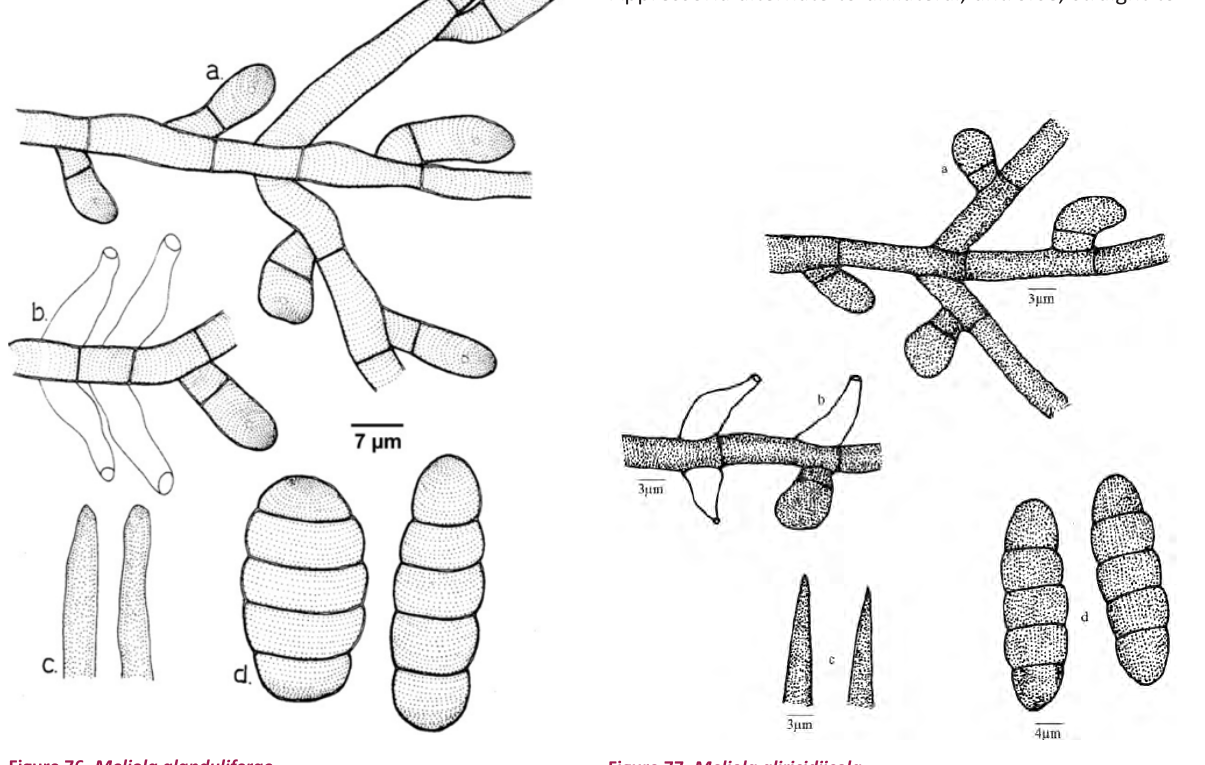
Figure 77. Meliola gliricidiicola a - Appressorium; b - Phialide; c - Apical portion of mycelial setae; d -